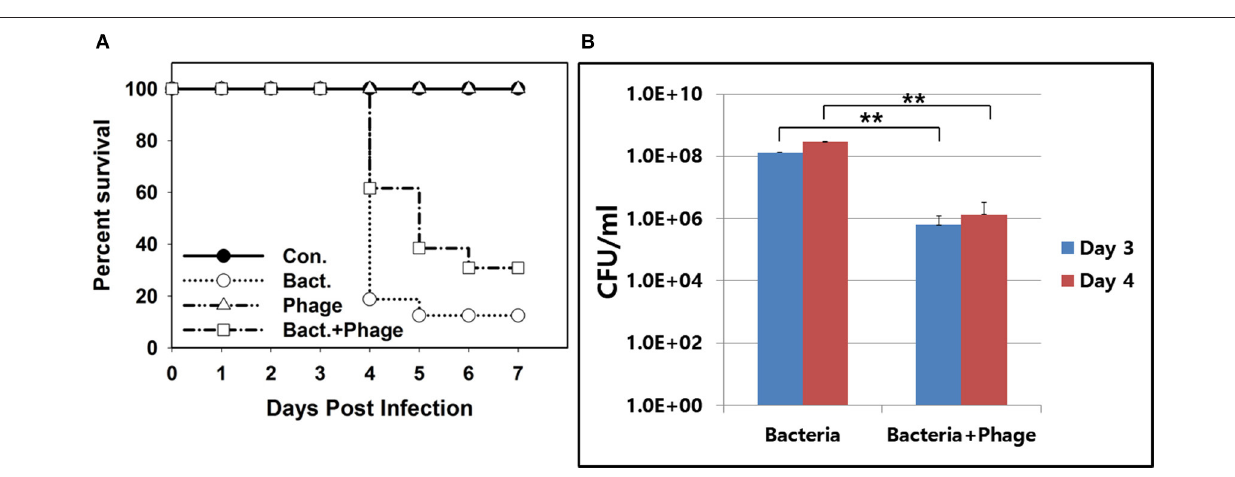
FIGURE 6 | In vivo efficacy of the phage cocktail containing PBAB08 and PBAB25 in a mice nasal infection model. (A) Survival of 4 groups of mice observed for 7 days after bacterial infection. Group 1 (closed circle) was inoculated with SM buffer only. Group 2 (open circle) was infected with MDR A. baumannii strain 28 only. Group 3 (triangle) was treated with the phage cocktail only. Group 4 (rectangle) was infected with A. baumannii and treated with the phage cocktail. (B) Bacterial load in lungs of infected mice in 3 and 4 days post-infection with or without phage treatment. ** P <